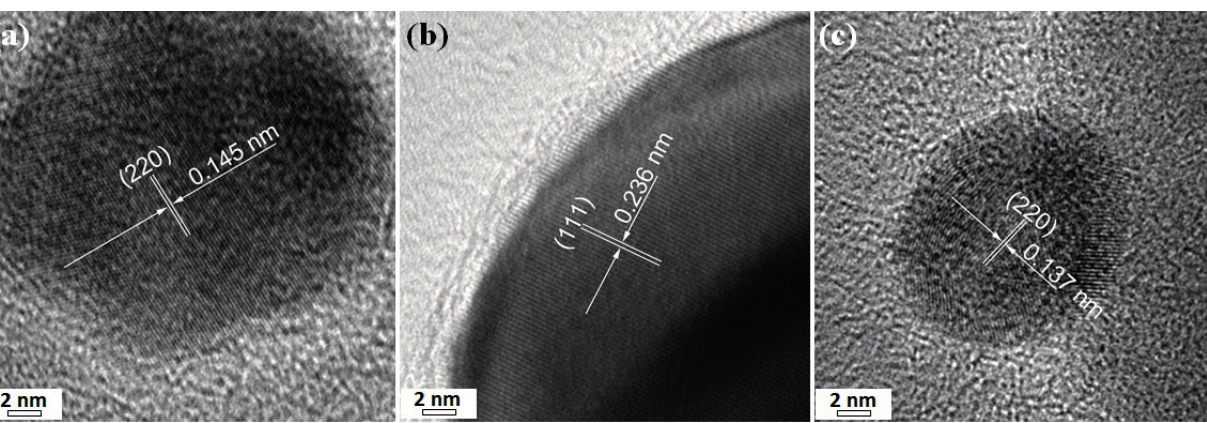
Figure 6. SEM ( a , b ), TEM ( c , d ) images of synthesized Pd samples; with the green chemistry method: ( a , c ) for the Pd sample MW-irradiated; for 3 min, and ( b , d ) for the Pd sample irradiated for 6 min.